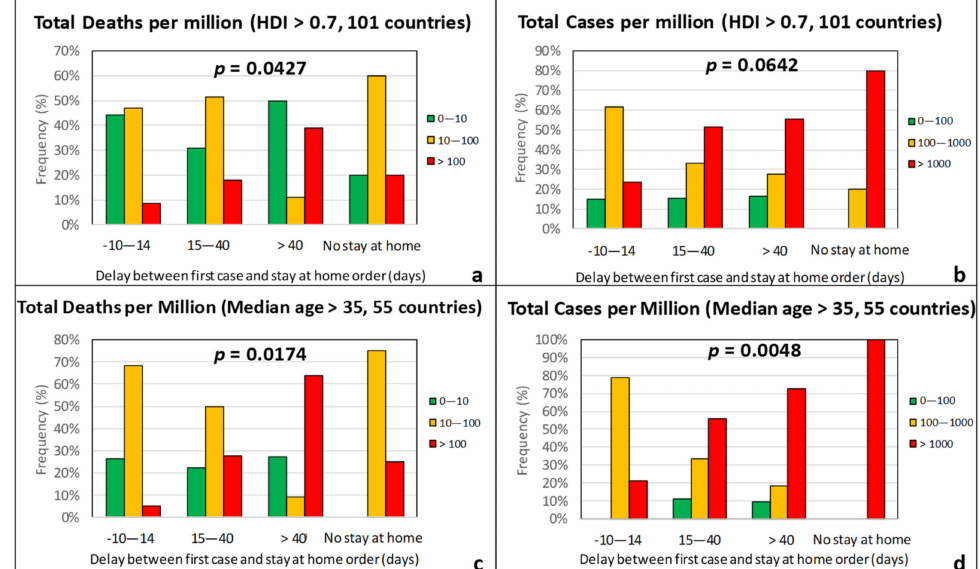
Figure 16. Frequency of total deaths per million (green: low, 0–10; orange: moderate, 10–100; red: high, > 100) and total cases per million (green: low, 0–100; orange: moderate, 100–1000; red: high, > 1000) as a function of the time di ff erence between first case and the imposition of “stay-at-home” measure for countries with an HDI over 0.7 ( a , b ) and a median age over 35 years ( c , d